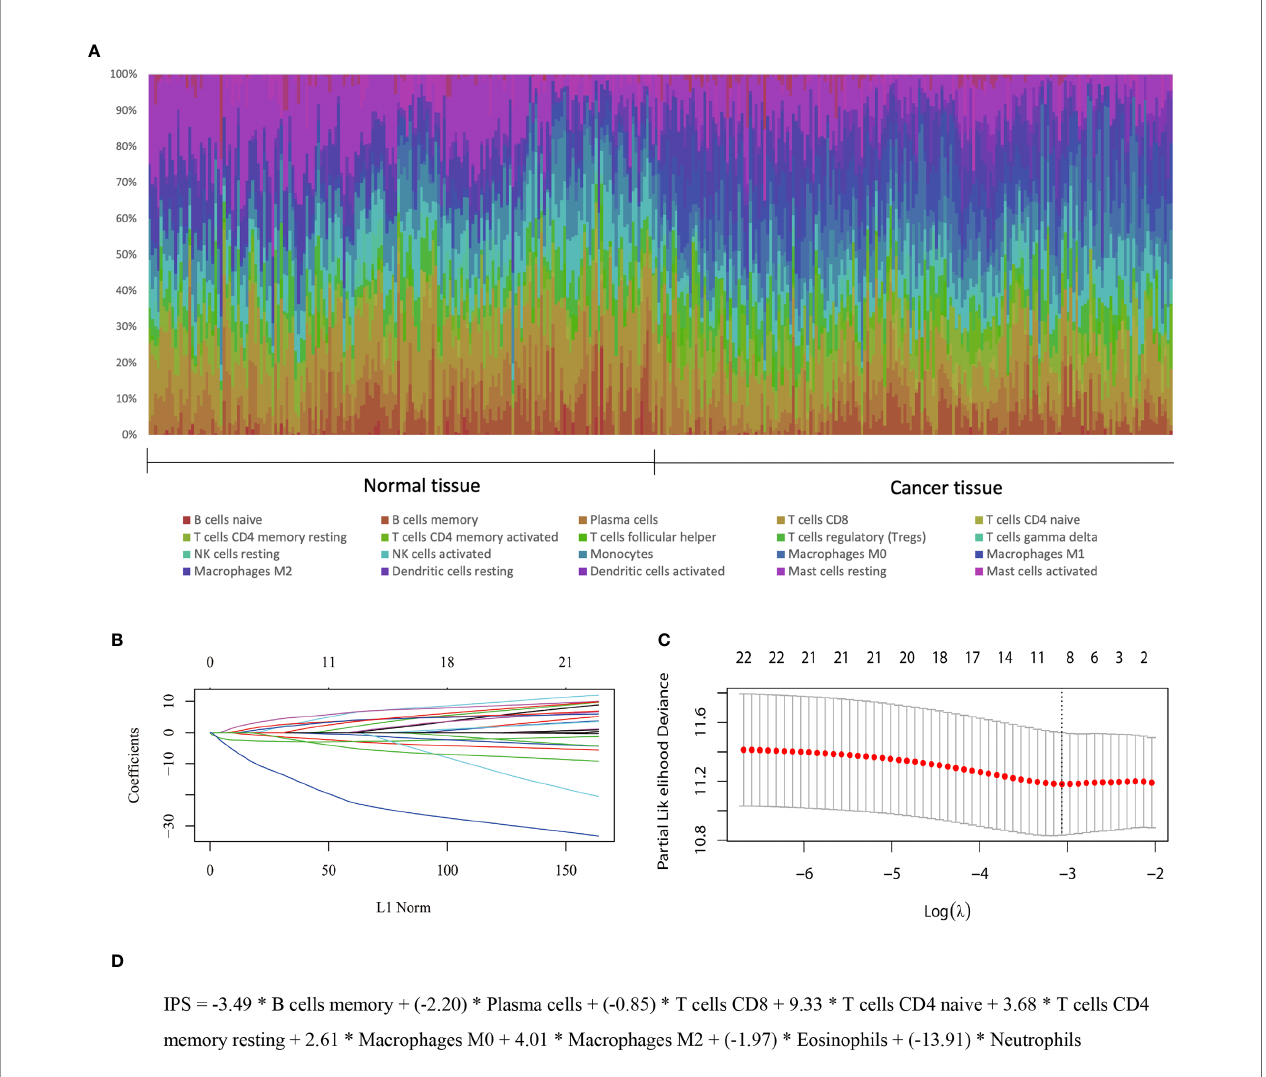
FIGURE 1 | Development of an IPS for ESCC. (A) Distribution of 22 in fi ltrated immune cells in 179 tumor tissues and paired normal tissues of ESCC patients in the GEO training set. Each bar represents the relative proportion of in fi ltrated immune cells of one tissue. (B, C) Tuning of the parameter l and determination of the coef fi cients of corresponding immune cell types in the IPS using the LASSO method. (D) The derived formula for the